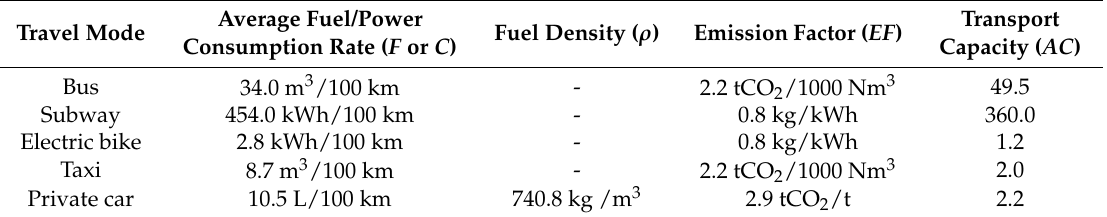
Table 2. Parameters of CO 2 emissions model [39–43].